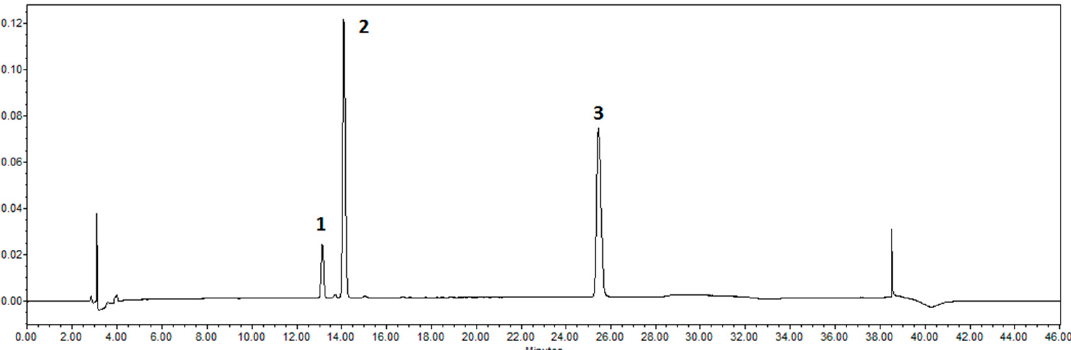
Figure 7. Chromatograms of standards detected by HPLC. 1–narirutin, 2–naringin, and 3–naringenin were identified as